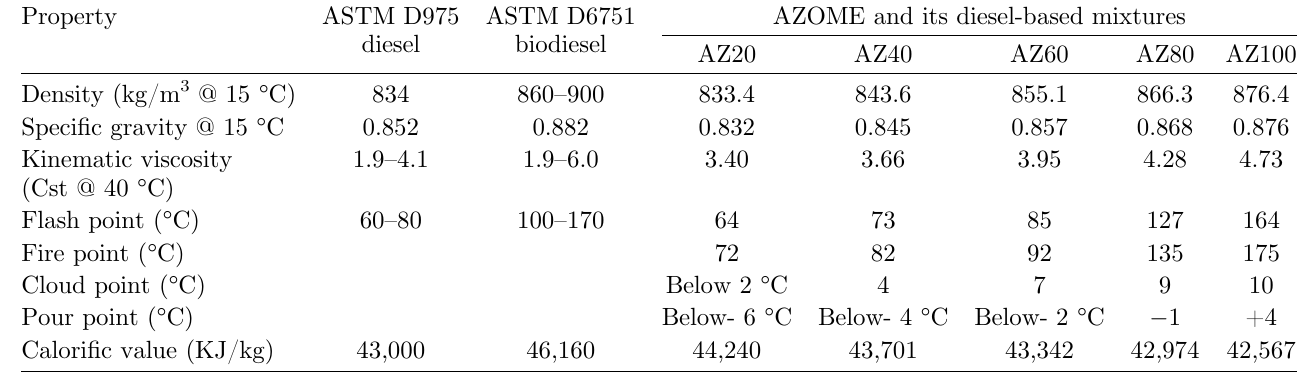
Table 2. Fuel properties of biodiesel and its blends.